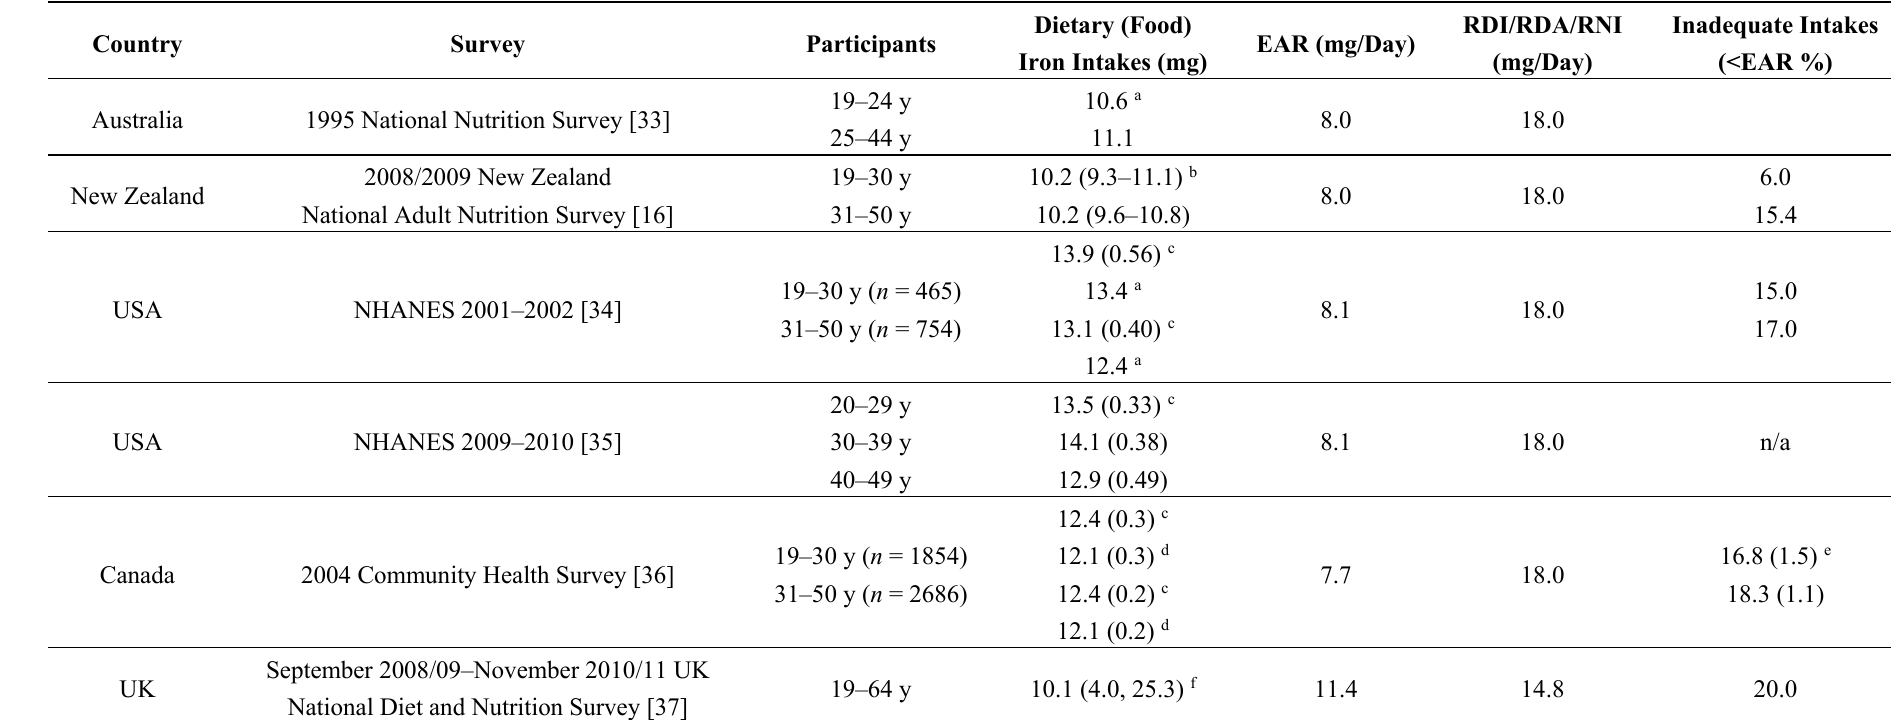
Table 3. Adequacy of population iron intakes among women living in industrialized